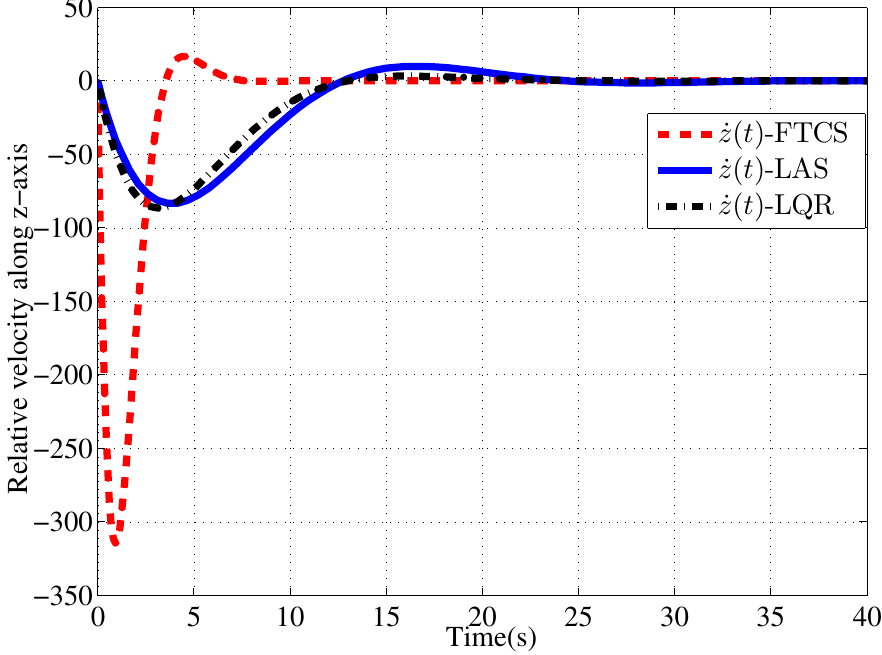
Figure 8. Relative velocity along z -axis under different control